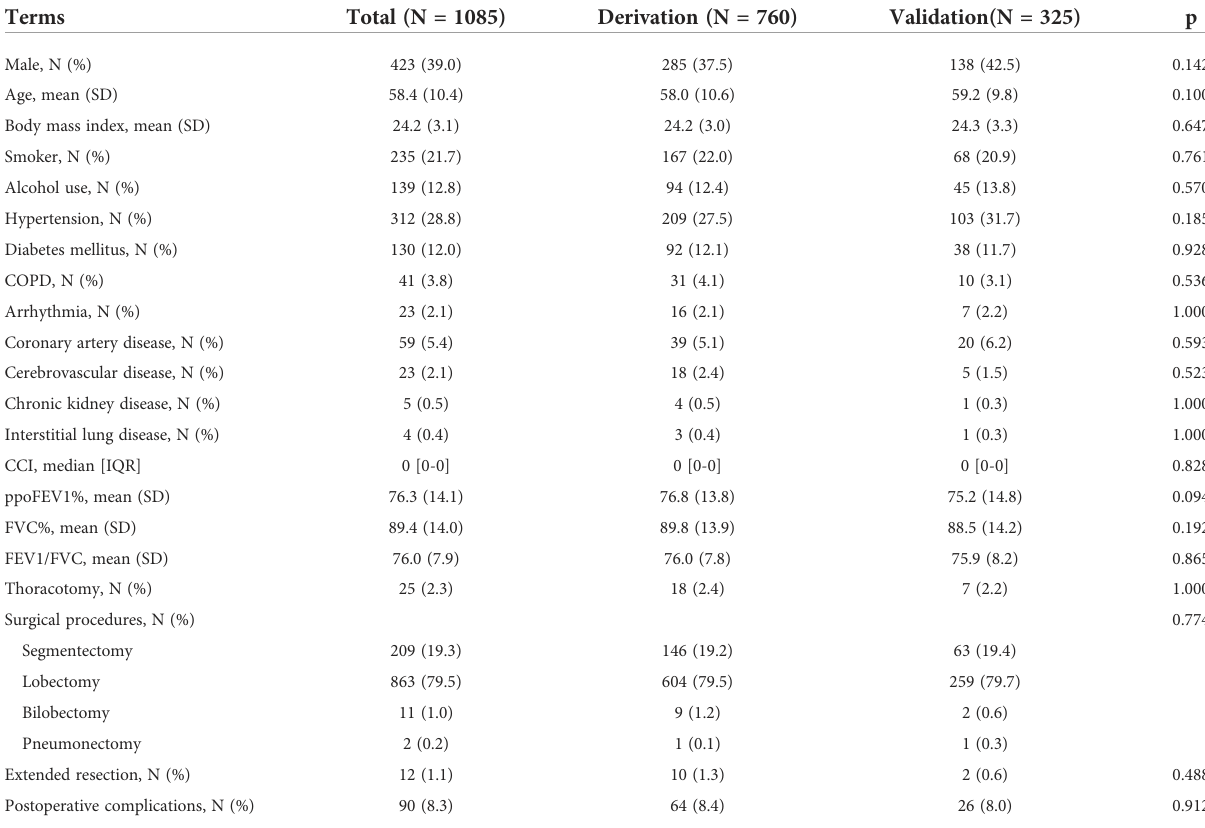
TABLE 1 Characteristics of the derivation cohort and the validation cohort.